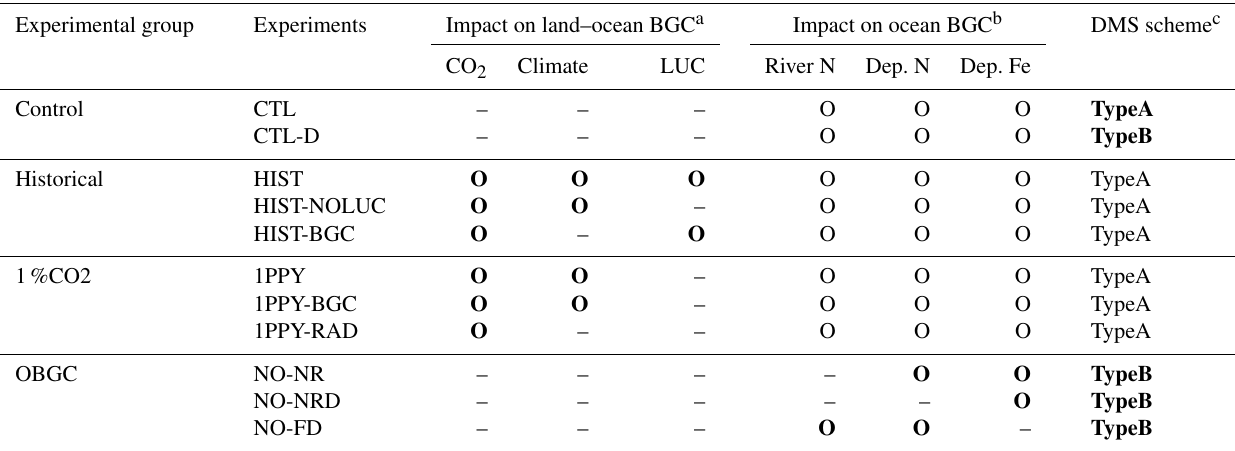
Table 2. Biogeochemical configurations in experiments, summarized as biogeochemical process settings. Bold characters represent the major differences between experiments within an experimental